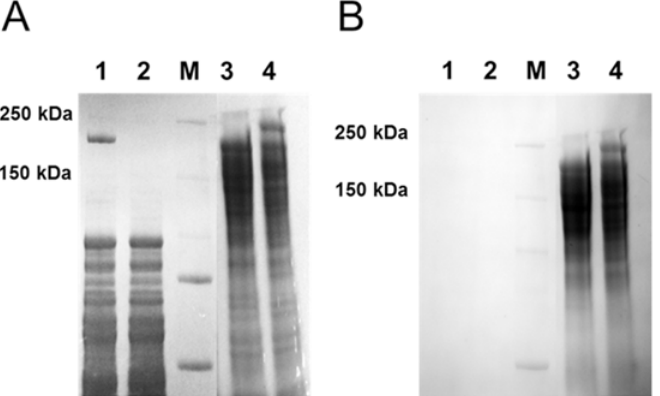
Fig 2. Evidence for extracellular glycosylation of CelA. Panel A, Coomassie stained gel. Panel B, the same gel stained with Glycoprotein Stain (G-Biosciences). Lane1, cell free extract from JWCB040 Δ pyrFA pDCW170:: celA (no signal sequence); Lane 2, cell free extract from JWCB046 Δ pyrFA ldh :: ISCbe4 Δ cbe1 Δ celA pDCW173:: celA (with the signal sequence); M, Molecular weight markers (Biorad); Lane 3, supernatant from JWCB029 Δ pyrFA ldh :: ISCbe4 Δ cbe1 Δ celA ; Lane 4, JWCB046 Δ pyrFA ldh :: ISCbe4 Δ cbe1 Δ celA pDCW173:: celA (with the signal sequence).